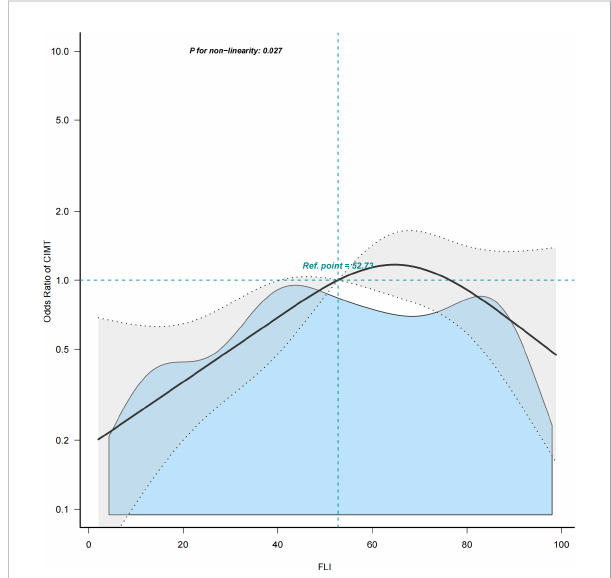
FIGURE 2 Restricted cubic spline plot of the association between FLI and CIMT. Solid and dashed lines represent the predicted and 95% con fi dence interval. FLI, fatty liver index; CIMT, carotid intima- media